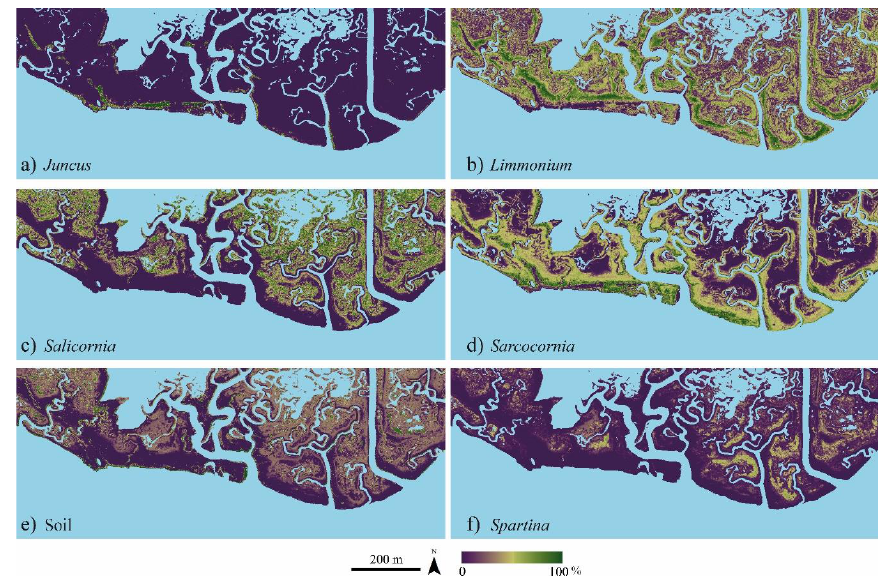
Figure 4. Maps of fractional abundance of each species and bare soil obtained based on the Random Forest (RF) soft classification method. Specifically, ( a ) ( b ) ( c ) ( d ) ( e ) and ( f ) are maps of fractional abundance of Juncus , Limonium , Salicornia , Sarcocornia , Soil and Spartina , respectively. Light blue areas represent water. Table 3. Accuracy information for RF soft classification. Jun = Juncus , Lim = Limonium , Sali = Salicornia , Sarc = Sarcocornia and Spar = Spartina. RMSE = root-mean-square error. Classes